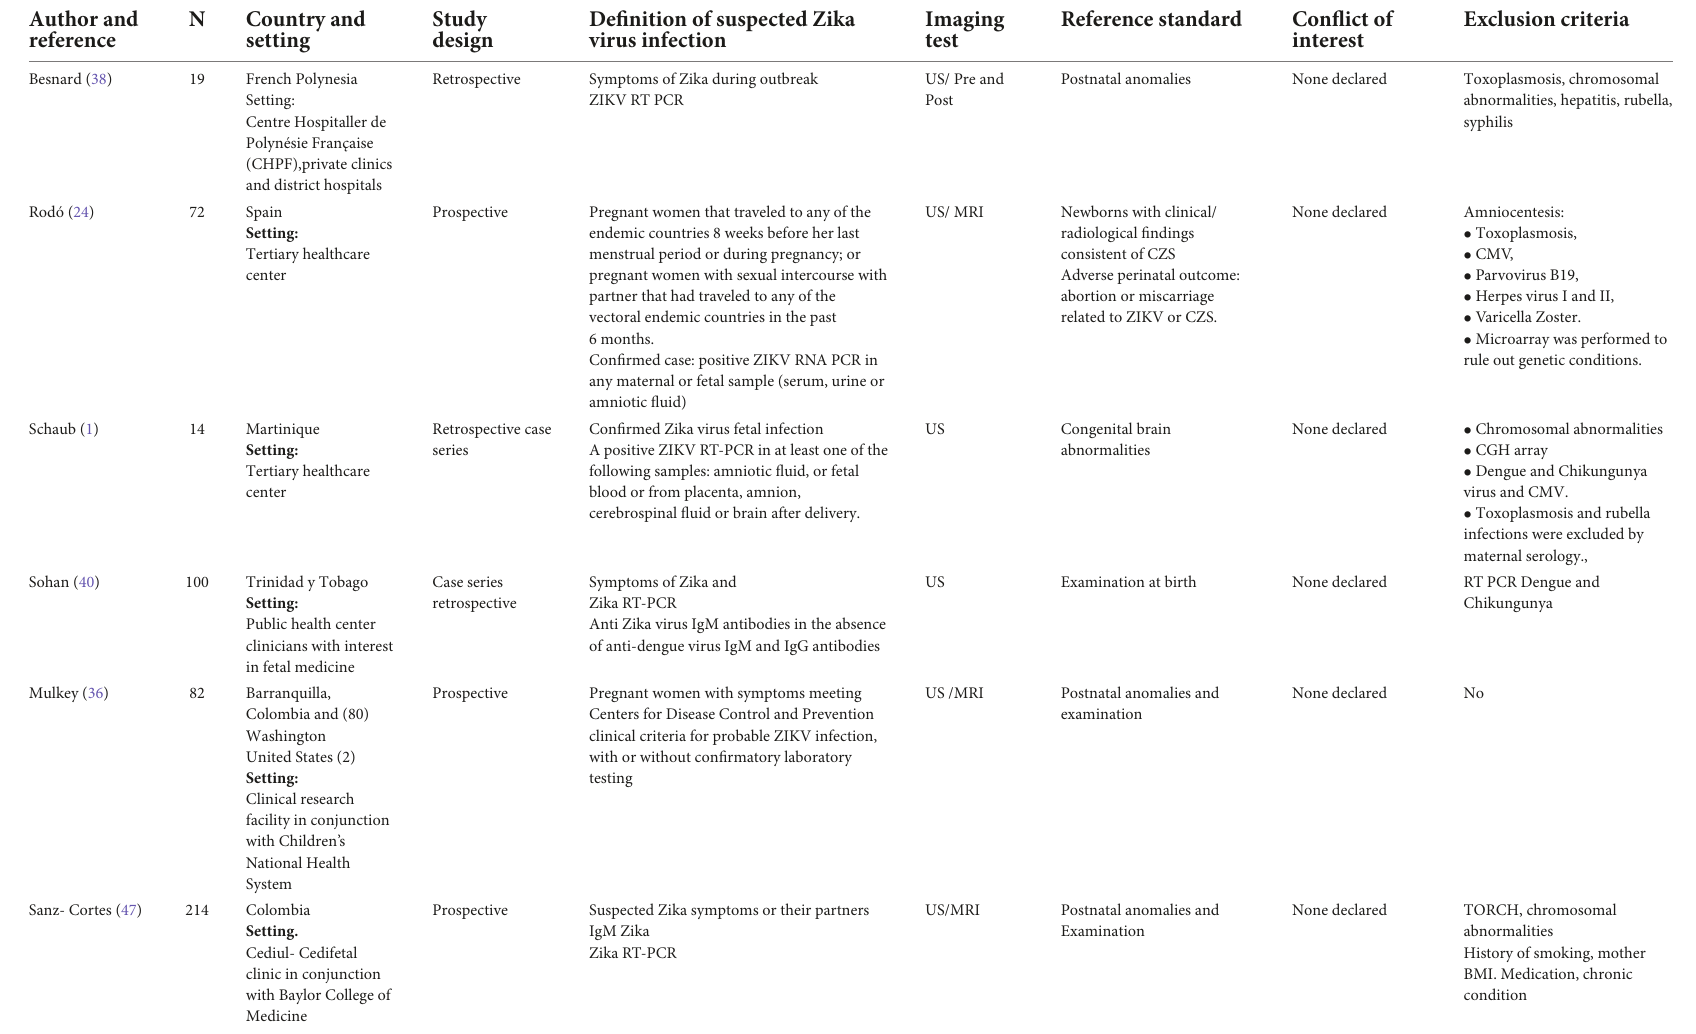
TABLE 1 Main characteristics of the included